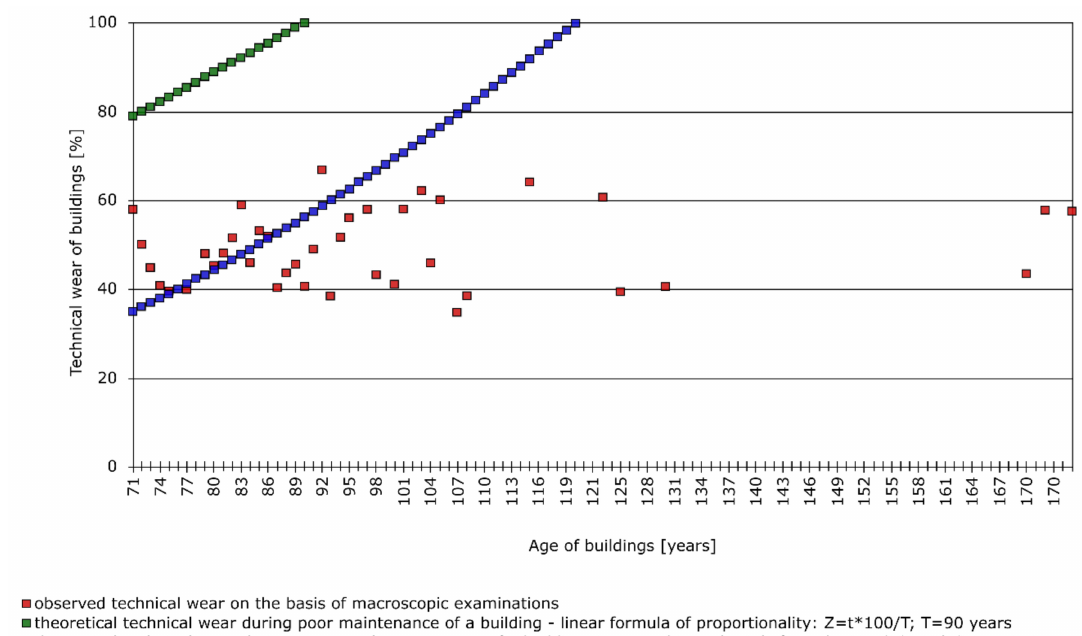
Figure 3. A diagram of the identified “over-durability” of the examined downtown tenement